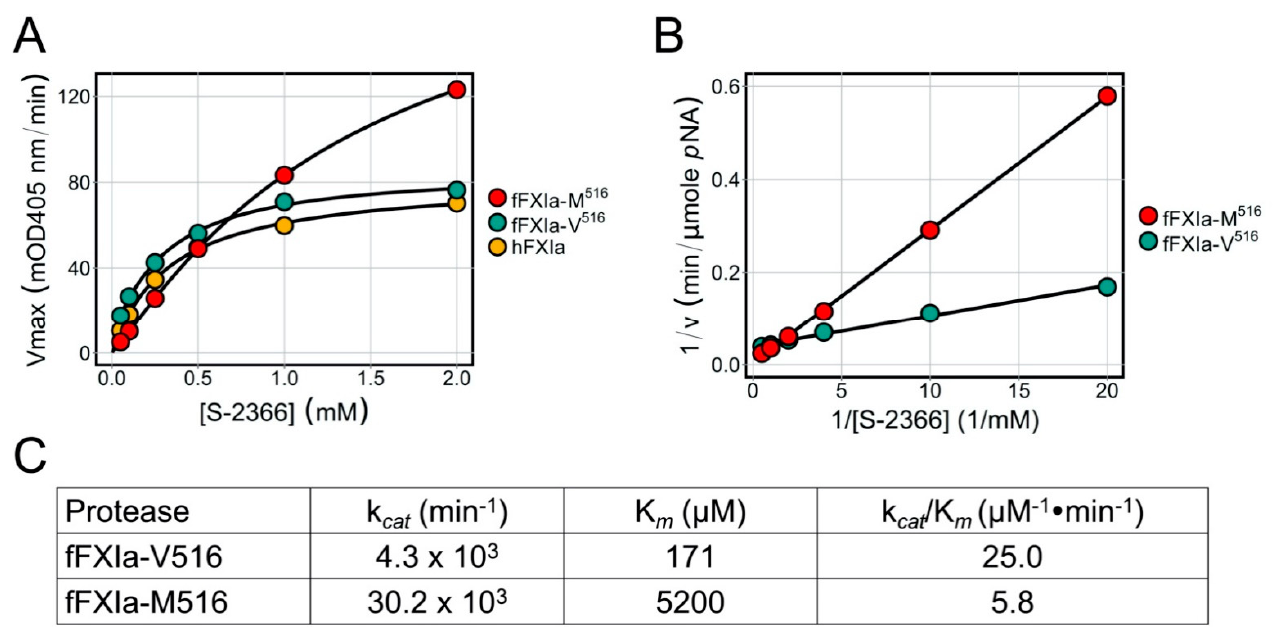
Figure 6. Chromogenic assays for FXIa activity ( A ) Six nanomolar human wild-type FXIa (hFXIa), feline wild-type FXIa (fFXIa-V516) or feline variant FXIa (fFXIa-M516) were incubated with varying concentrations of S-2366, and change in OD405 nm over time was followed on a microtiter spectrophotometer. ( B ) Inverse reciprocal plots for data in panel C. Values for OD405 nm/min were converted to p NA formed per unit time. ( C ) Kinetic parameters for S-2366 cleavage by FXIa derived from the reciprocal plots in panel B.